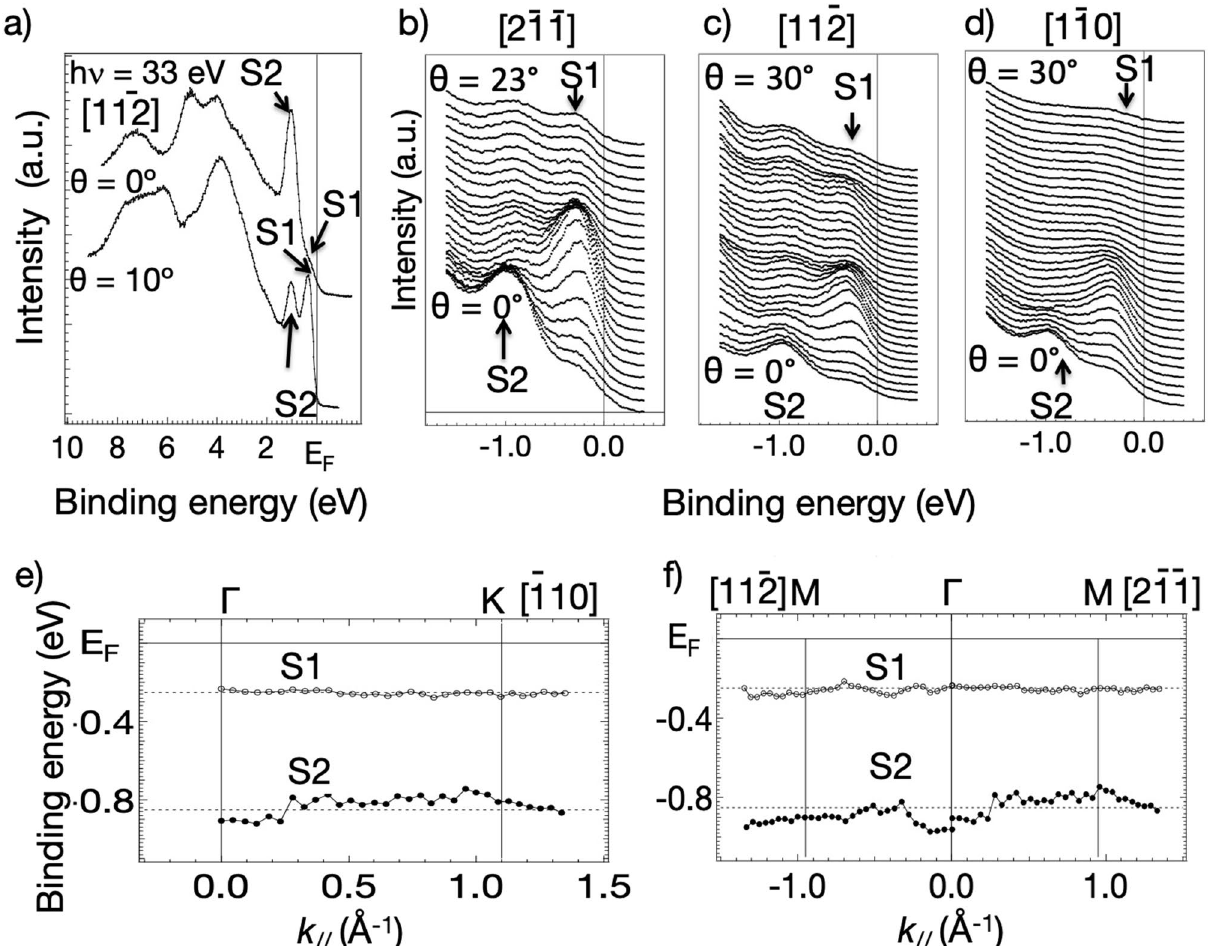
Figure 2. ( a ) ARPES spectra recorded at 33 eV of the valence region of Si(111)(7 × 7) at normal emission (θ = 0°) and at a polar angle θ = 10° in [ 112 ] azimuth. ( b – d ) ARPES of the energy range of the S1 and S2 states at a sequence of different polar emission angles in each of the three principal azimuthal directions. ( e , f ) mapping of the S1 and S2 initial state energies as a function of k//, in the two principal azimuths. See Figure S1 for further details. The data have been measured using setup I, described in Figure S2 (Figures S1 and S2 described in supplementary